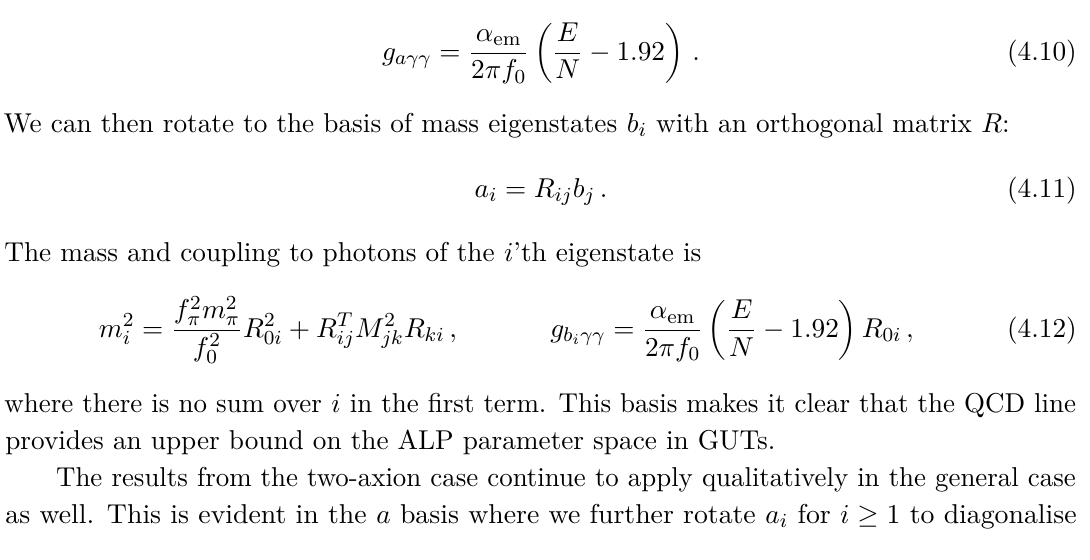
= 10 12 GeV , f = 10 13 GeV , 1 2 = 10 12 GeV , f = 10 11 GeV and 1 2